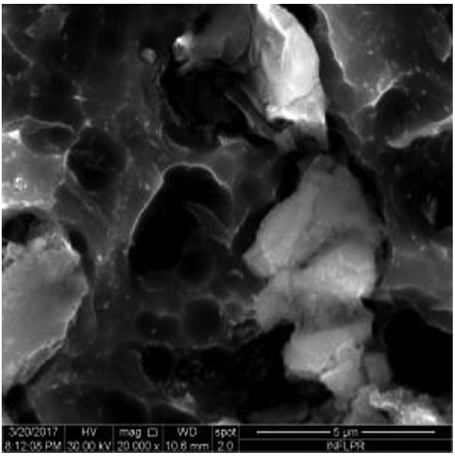
Figure 9: SEM image of sample S9 at a magni fi cation of 20k × .